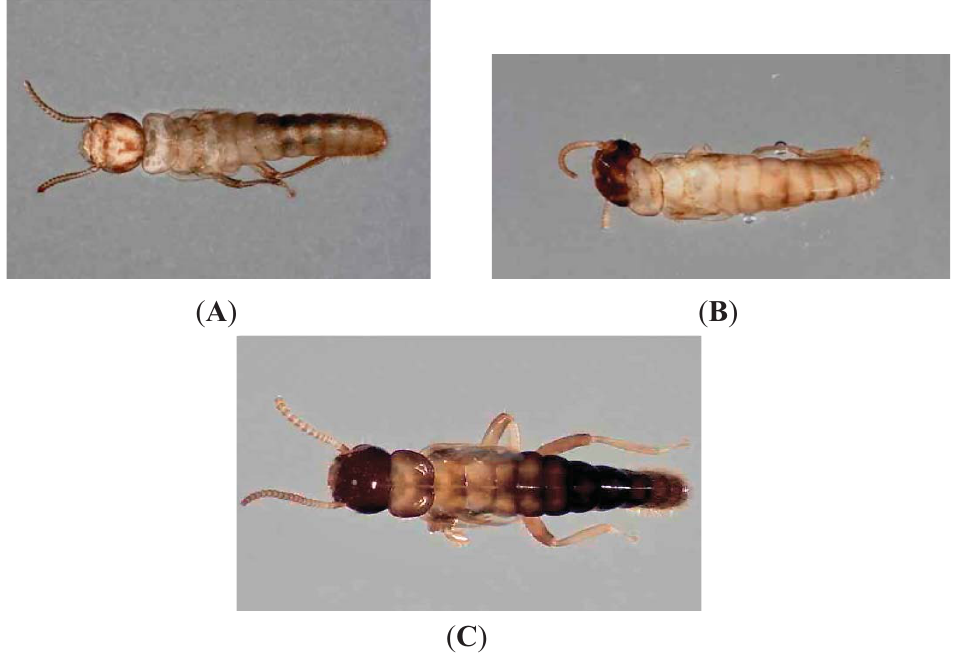
Figure 1. Photographic representation of neotenic phenotype designations based on the extent of cuticle scleritozation. ( A ) Regular neotenic; ( B ) Black-headed neotenic; ( C ) Black